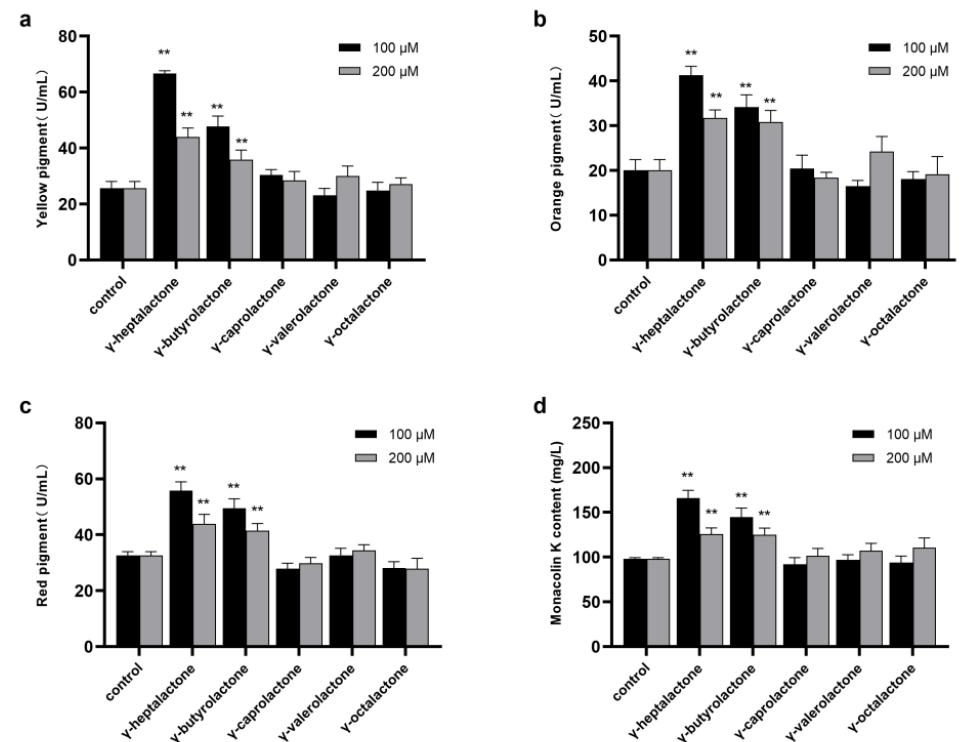
Figure 1. Effect of five lactones ( γ -heptalactone, γ -butyrolactone, γ -caprolactone, γ -valerolactone, and γ -octalactone) on the MPs and MK synthesis in M. purpureus M1. ( a ) Yellow pigment, ( b ) orange pigment, ( c ) red pigment, and ( d ) MK. Data are expressed as the mean ± SD ( n = 3). ** p < 0.01, compared to the control.